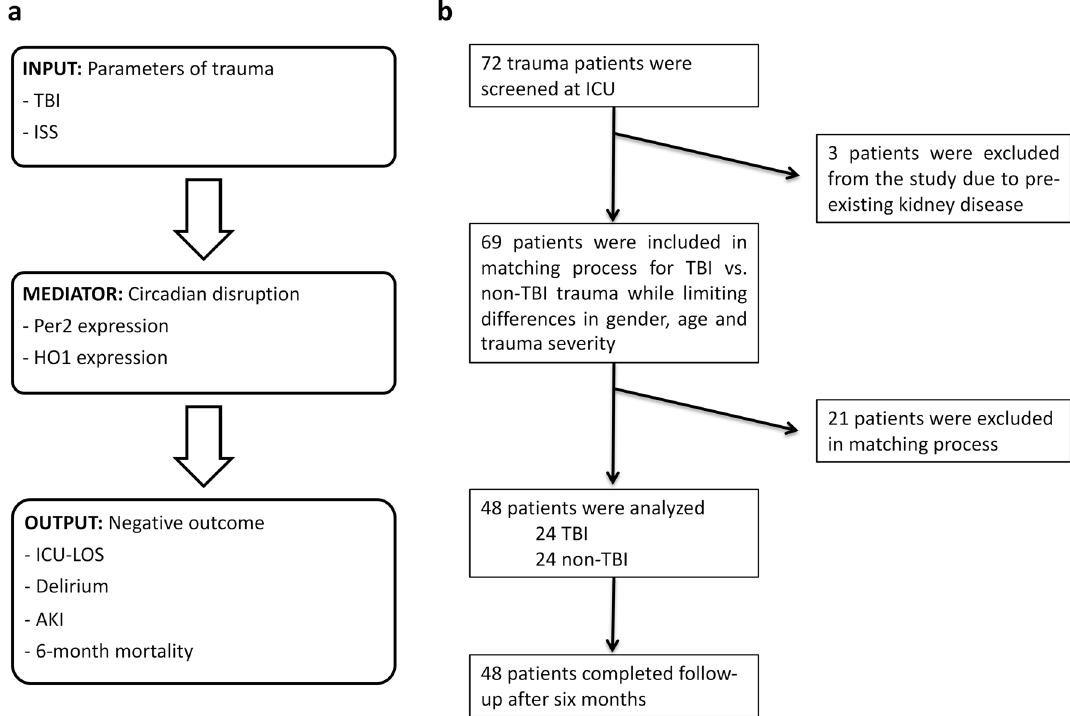
Figure 1. Study conception. (a) Schematic illustration of hypothesized relationship between input (parameters of trauma) and output (negative outcome) parameters with mediating variables (circadian disruption and heme metabolism measured via PER2/HO1 expression). (b) Selection of polytrauma patients that were analyzed for circadian mRNA expression. Patients were sorted in matched pairs (criteria: gender, age, trauma severity ( ISS injury severity score)) to form patient groups of TBI and non-TBI for later between-group comparison. TBI traumatic brain injury, ISS injury severity score, PER2 period circadian regulator 2, HO1 heme oxygenase 1, AKI acute kidney injury, ICU intensive care unit, LOS length of